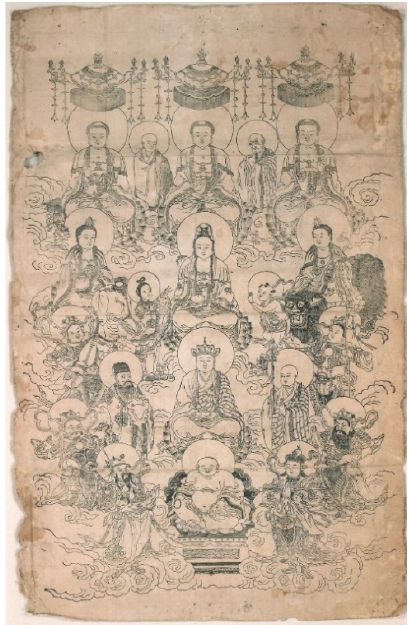
Figure 13. Assembly of Deities . Early 20th century. Print on paper. 69.0 × 44.0 cm. Puyongsa, Kimje, North Chŏlla Province. After (Kungnip Kongju Pangmulgwan 2012, p. 148).